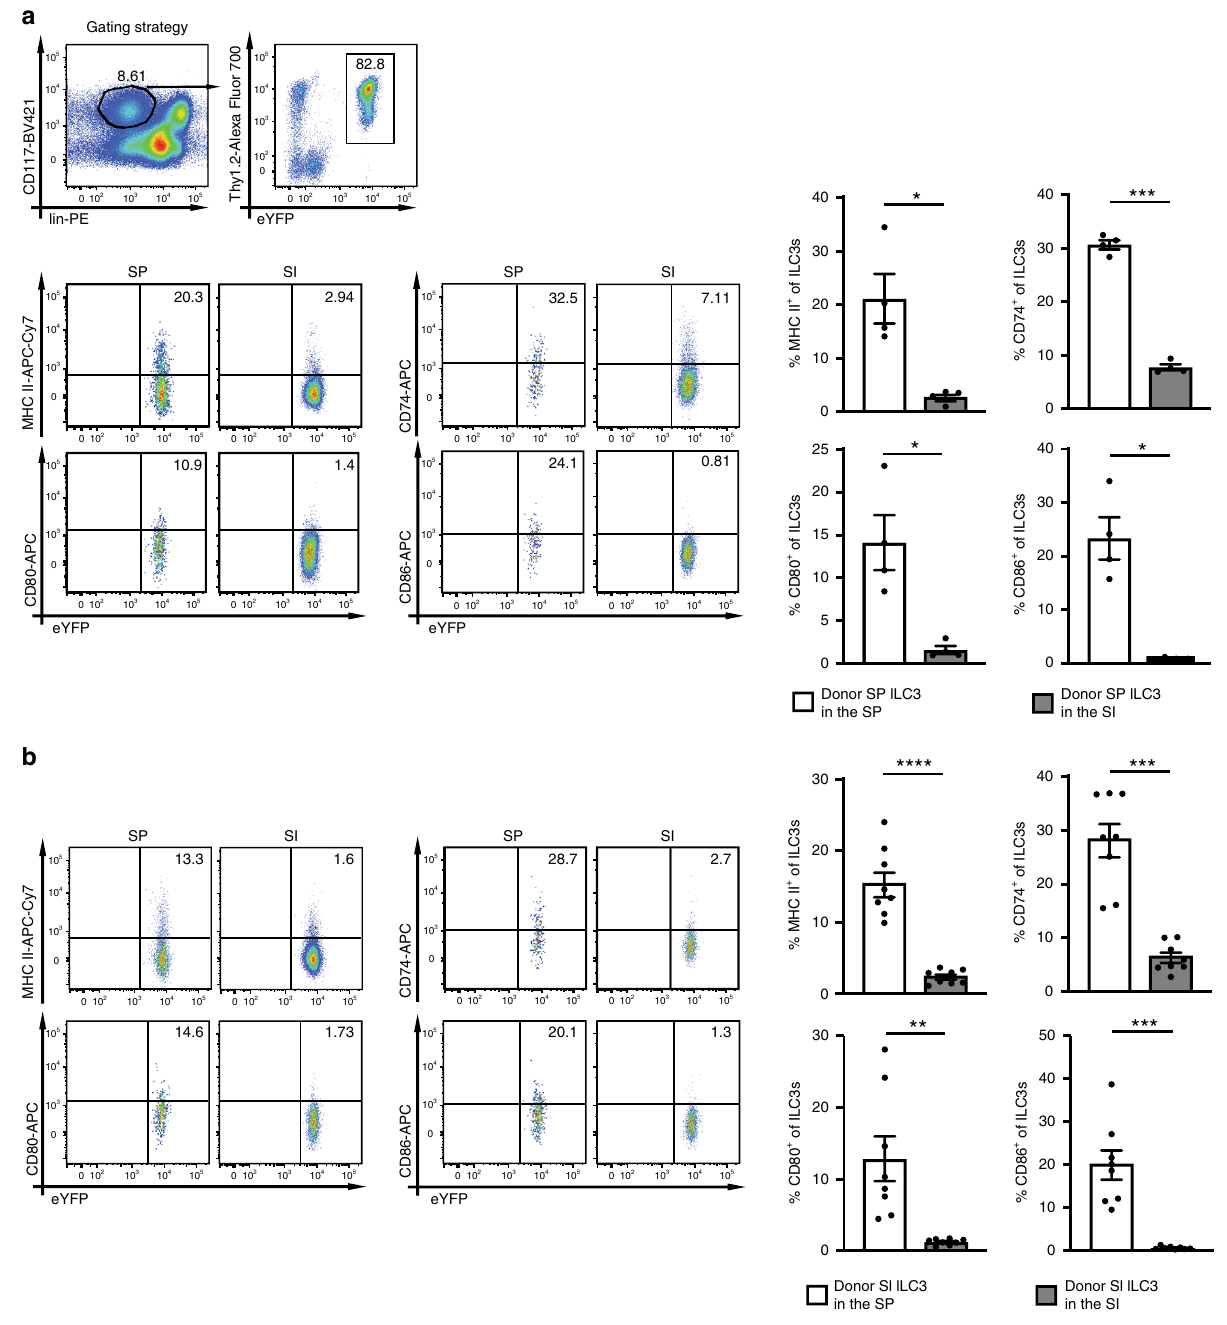
Fig. 3 The tissue localization determines the frequency of ILC3s with an APC phenotype. SP ILC3s ( a ) or SI ILC3s ( b ) from Ror γ t fm + Rag2 − / − mice were i.v. injected into Rag2 − / − Il2rg − / − mice. Cells were sort-puri fi ed as depicted in Supplementary Fig. 1a. Five weeks after transfer the expression of MHC II, CD80, CD86, and CD74 on donor derived ILC3s in the SP and SI of recipient mice was analyzed. ILC3s were gated as depicted in ( a ). a n = 4 distinct samples of four independent experiments and b n = 8 distinct samples of fi ve independent experiments. Each symbol represents a sample and the bar graph represents the mean ± s.e.m. * P ≤ 0.05; ** P ≤ 0.01; *** P ≤ 0.001; **** P ≤ 0.0001, calculated with two-tailed paired Student ’ s t test. Source data are provided as a Source Data